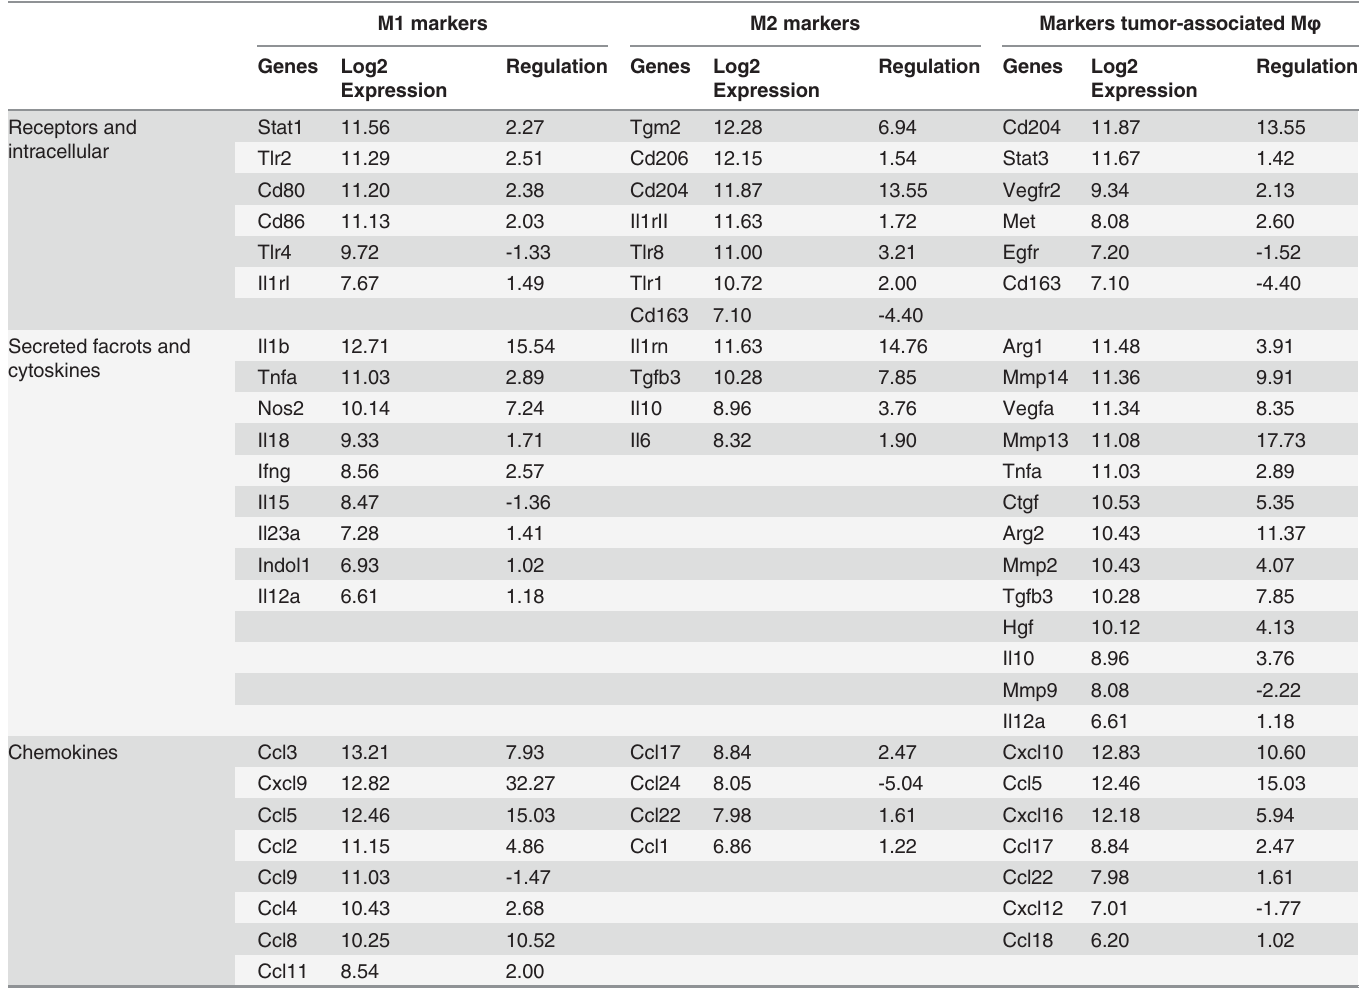
Table 4. Expression of known M1, M2, and TAM marker genes in our GAMs data set. M1